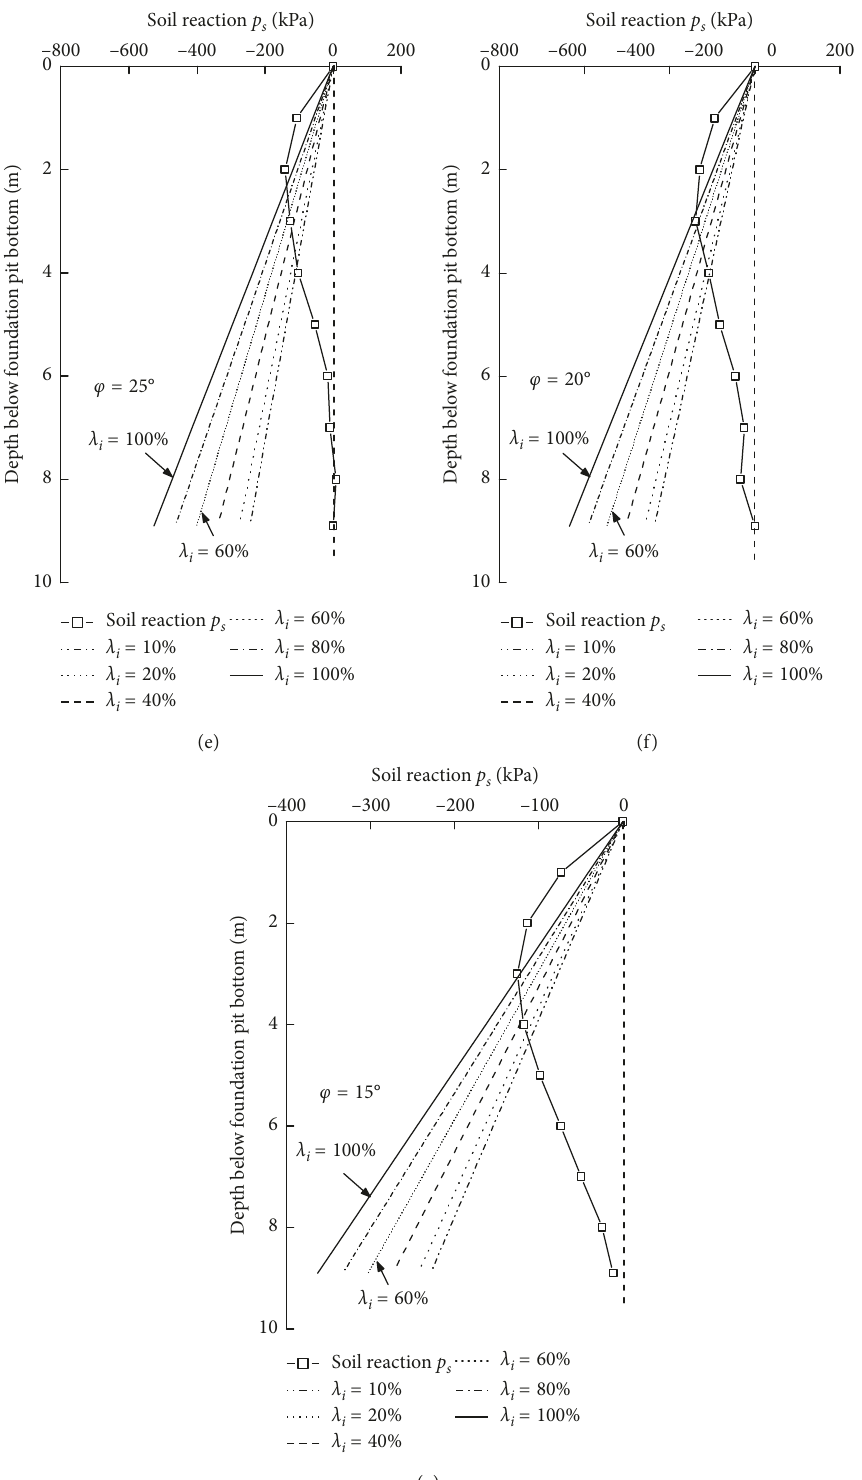
Figure 5: Soil reaction and deformation state bearing capacity of the built-in section at different internal friction angles: (a) φ � 45 ° , (b) φ � 40 ° , (c) φ � 35 ° , (d) φ � 30 ° , (e) φ � 25 ° , (f) φ � 20 ° , and (g) φ � 15 °